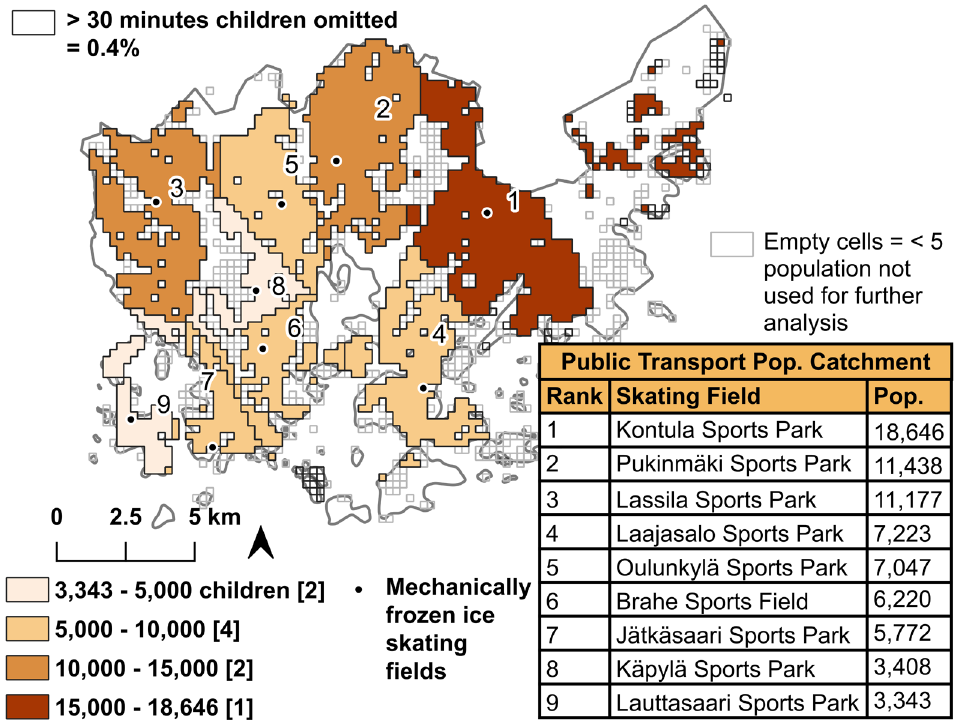
Fig. 6. Population catchment areas for children and adolescents of mechanically frozen ice skating fields based on travel time by public transport.